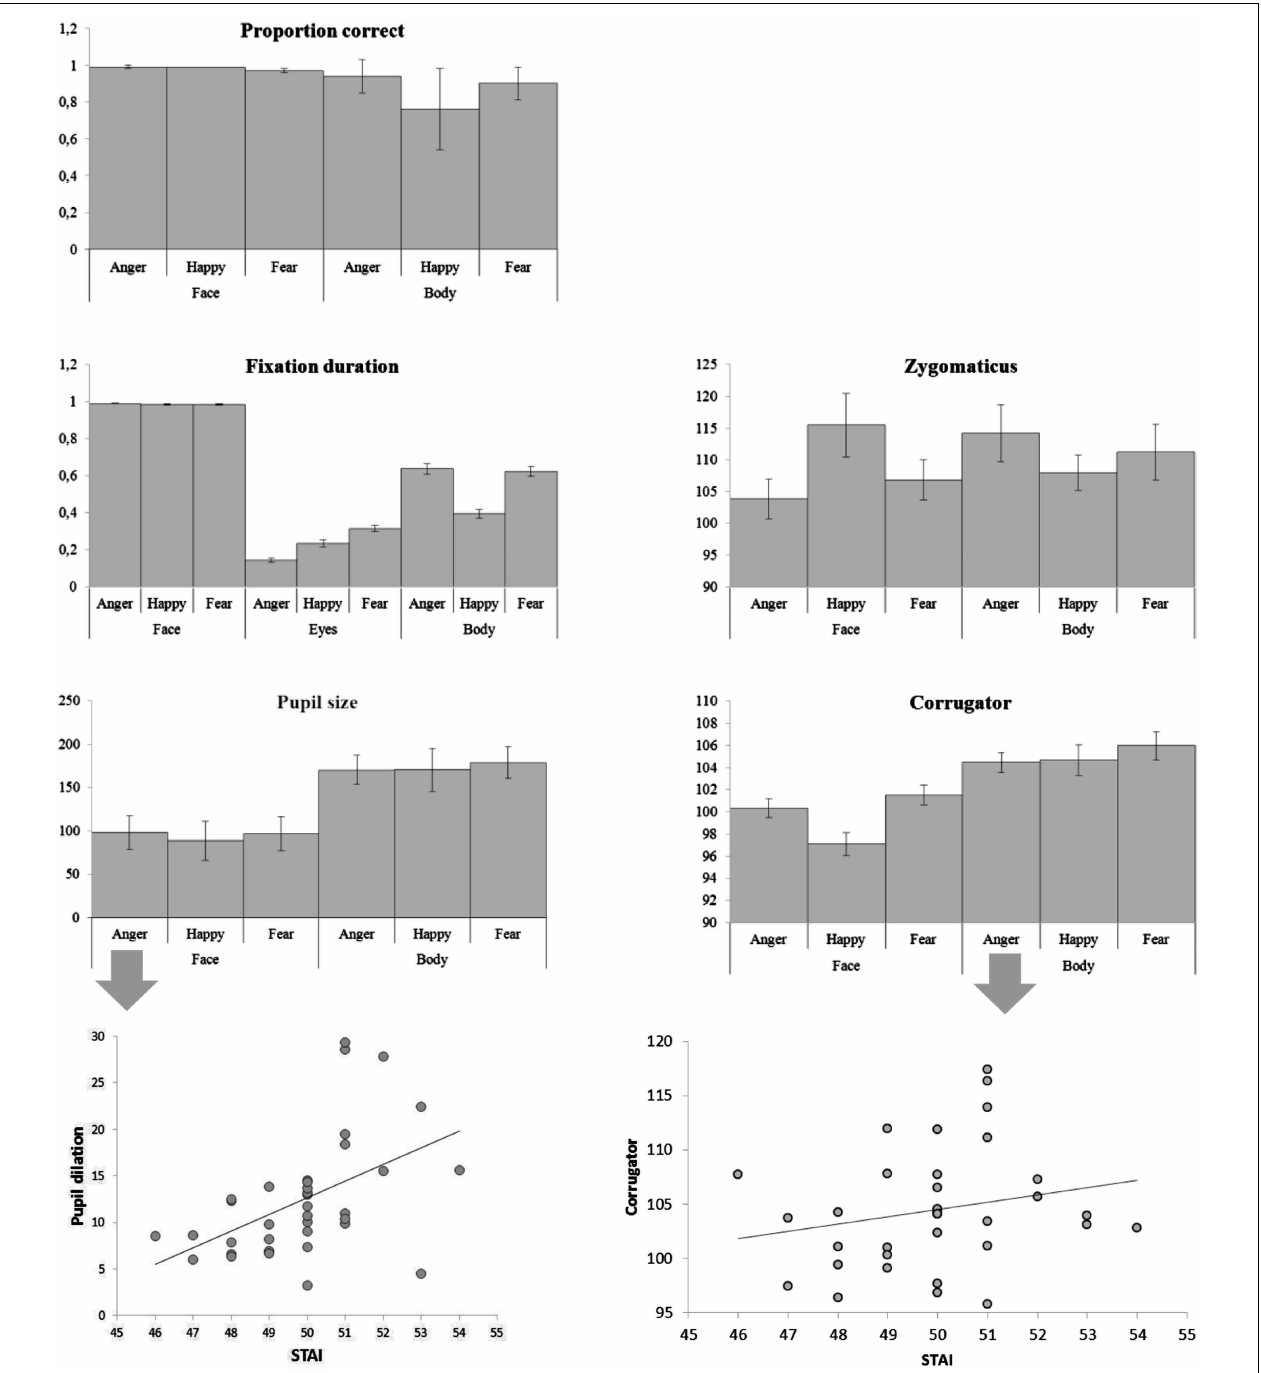
FIGURE 3 | Categorizing facial and bodily expressions of emotion. Means of all measurements.The error bars represent the standard error.